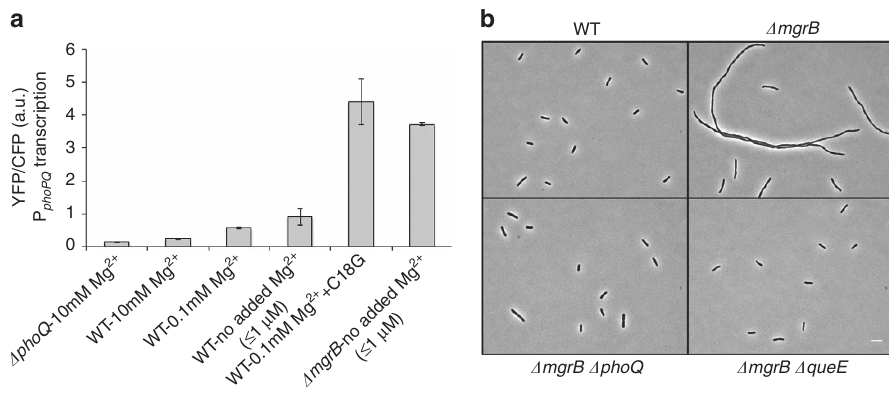
Figure 2 | Filamentation is associated with conditions that strongly stimulate PhoQ/PhoP. ( a ) Measurement of phoPQ promoter activity from a P phoPQ - yfp transcriptional reporter in wild-type (TIM148), D phoQ (TIM229) and D mgrB (AML22) strains in minimal medium at indicated Mg 2 þ concentration. For wild-type cells grown in the presence of antimicrobial peptide C18G, C18G was added to a final concentration of 9 m gml (cid:2) 1 . Cells were grown until an OD 600 ¼ 0.2–0.3 and fluorescence was measured by microscopy. Data represent means and s.d.’s from at least three independent experiments. ( b ) Cellular morphology of wild-type (TIM92), D mgrB (AML20), D mgrB D phoQ (AML17) and D mgrB D queE (JNC21) cells grown in minimal medium with no added Mg 2 þ . Scale bar, 5 m m.